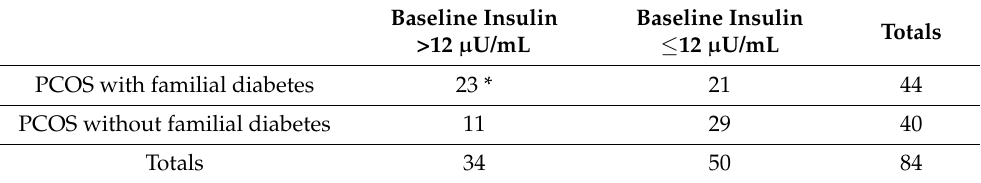
Table 3. Observed frequencies of familial diabetes and baseline insulin levels ≥ 12 µ IU/mL. Baseline Insulin Baseline Insulin Totals ≤ 12 µ U/mL >12 µ U/mL PCOS with familial diabetes 23 * 21 44 PCOS without familial diabetes 11 29 40 Totals 34 50